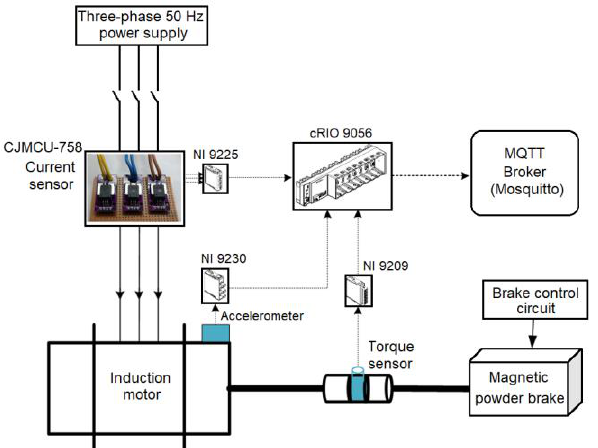
Figure 5. A schematic diagram of the experimental testbed designed and utilized in this study .